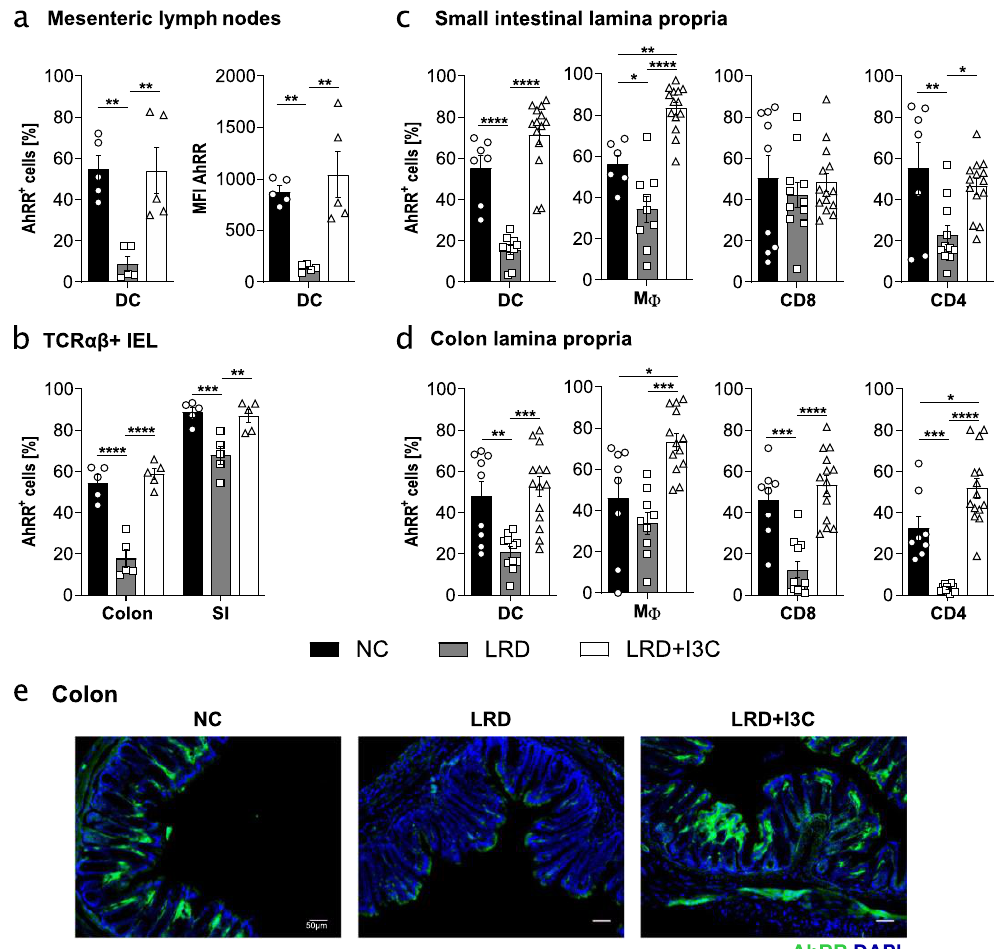
Figure 2. Dietary AhR ligands drive expression of Ahrr in intestinal immune cells. AhRR E/+ mice were Figure 3. carbinol (LRD + I3C) (2 g/kg). Frequency of Ahrr expressing dendritic cells (DCs) and mean fluorescent intensity (MFI) of DCs in the mesenteric lymph nodes (mLNs) ( a ); frequency of Ahrr expressing T cell receptor (TCR)αβ + IELs (intraepithelial lymphocytes) in colon and small intestine (SI) ( b ); and frequency of Ahrr expressing DCs, MΦ, CD4 + T cells, and CD8 + T cells isolated from the lamina propria of the SI ( c ) and colon ( d ). ( e ) After paraformaldehyde (PFA) fixation, cryosections of the colon were stained with DAPI in addition to the endogenous Enhanced Green Fluorescent Protein (EGFP) reporter. Data are pooled from at least two independent experiments ( n = 5–14), scale bar: 50 µm. Results are shown as mean +/− SEM and significance was analyzed by one-way ANOVA corrected for multiple comparisons by the Tukey’s post hoc test (* p < 0.05, ** p < 0.01, *** p < 0.001, **** p < 0.0001). Pictures are representative of at least three different mice from at least two independent experiments. DAPI = 4 ′ ,6-Diamidin-2-phenylindol.